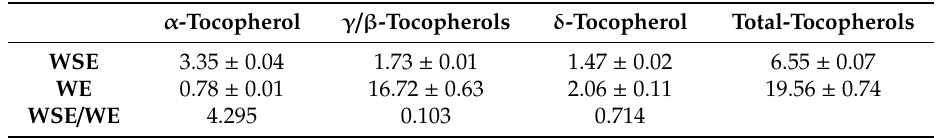
Table 2. Tocopherol content (mg / 100 g extract ± SD (standard deviation)) determined in walnut septum extract (WSE) and walnut kernel (with skin) extract (WE) by LC-MS/MS. α -tocopherol γ / β -tocopherols